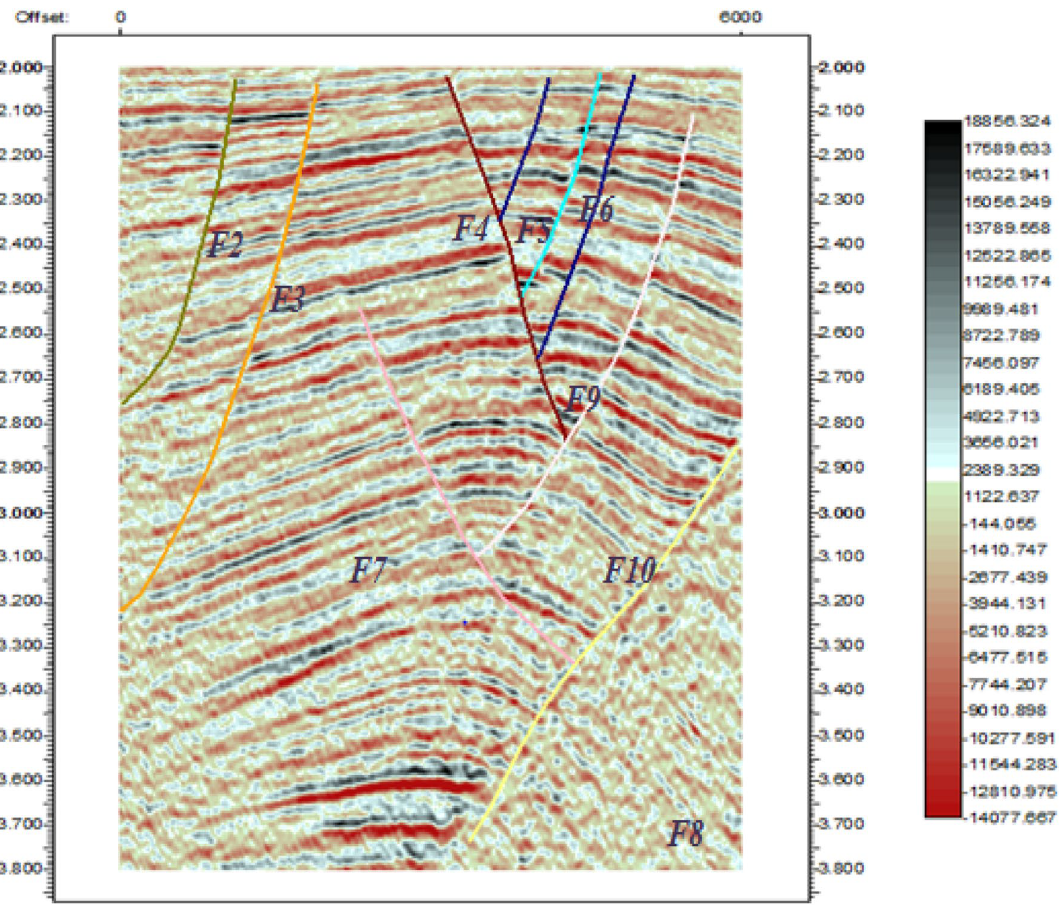
Fig. 4 Seismic volume showing picked faults. This figure shows the interpreted seismic section, indicating the positions of the picked faults on the seismic